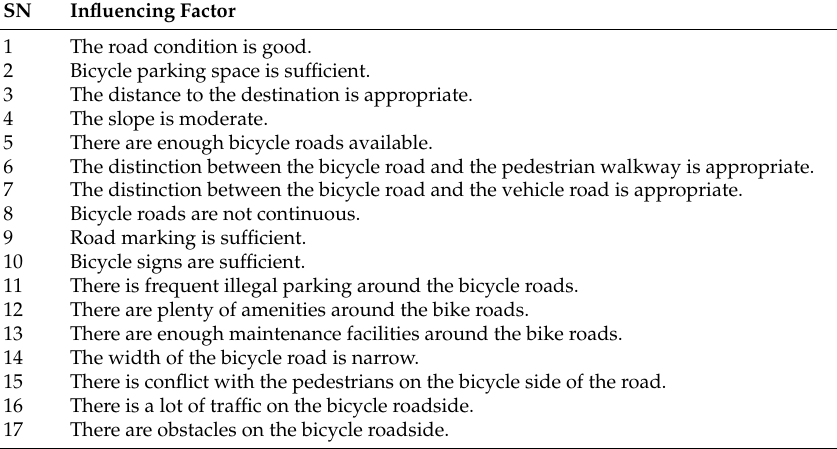
Table 1. Factors that affect respondents’ use of bicycles